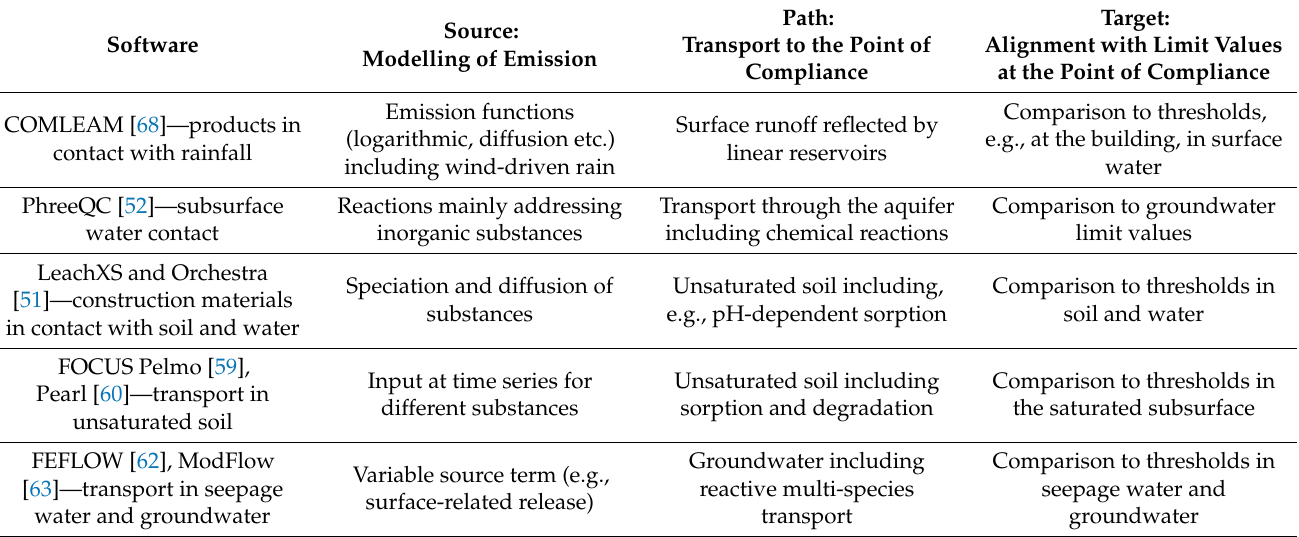
Table 1. Examples of software used in science and